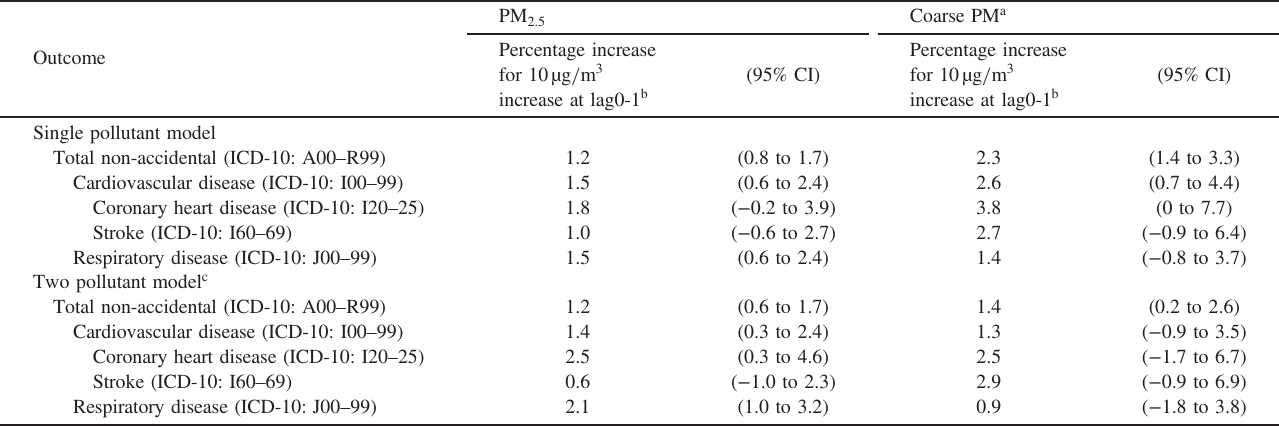
Table 4. Pooled estimates for non-accidental mortality associated with PM 2.5 and coarse PM in 77 Japanese cities, April 2012 to March